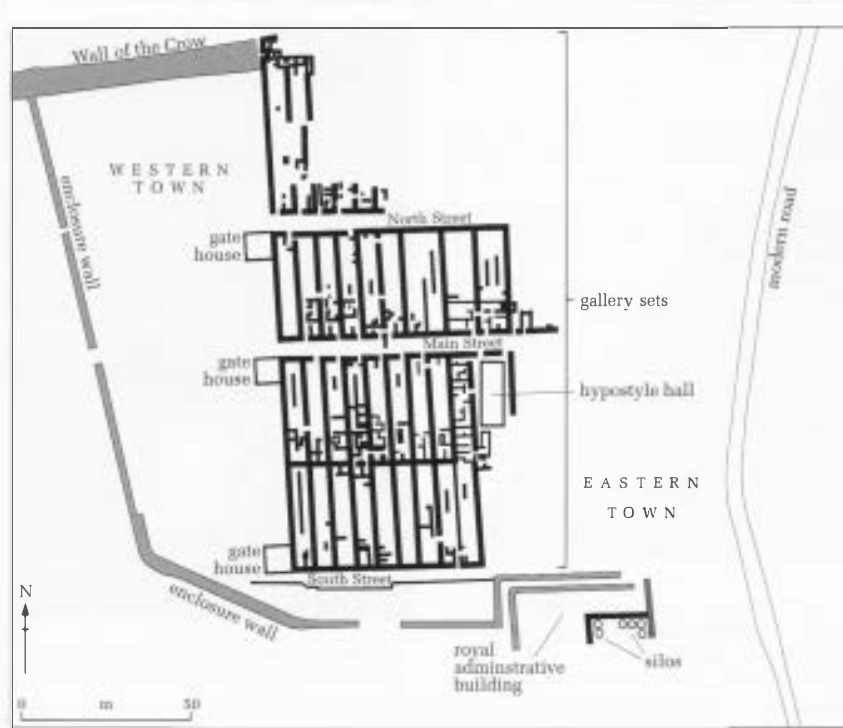
Figure 2 Simplified plan of the settlement of the pyramid builders at Giza. Redrawn from a plan prepared by Mark Lehner, director of the Giza Plateau Mapping Project. animal remains was undertaken. All ani­ mal bones from the excavation were retrieved (more than 152,000 items to date) and they are being analyzed by